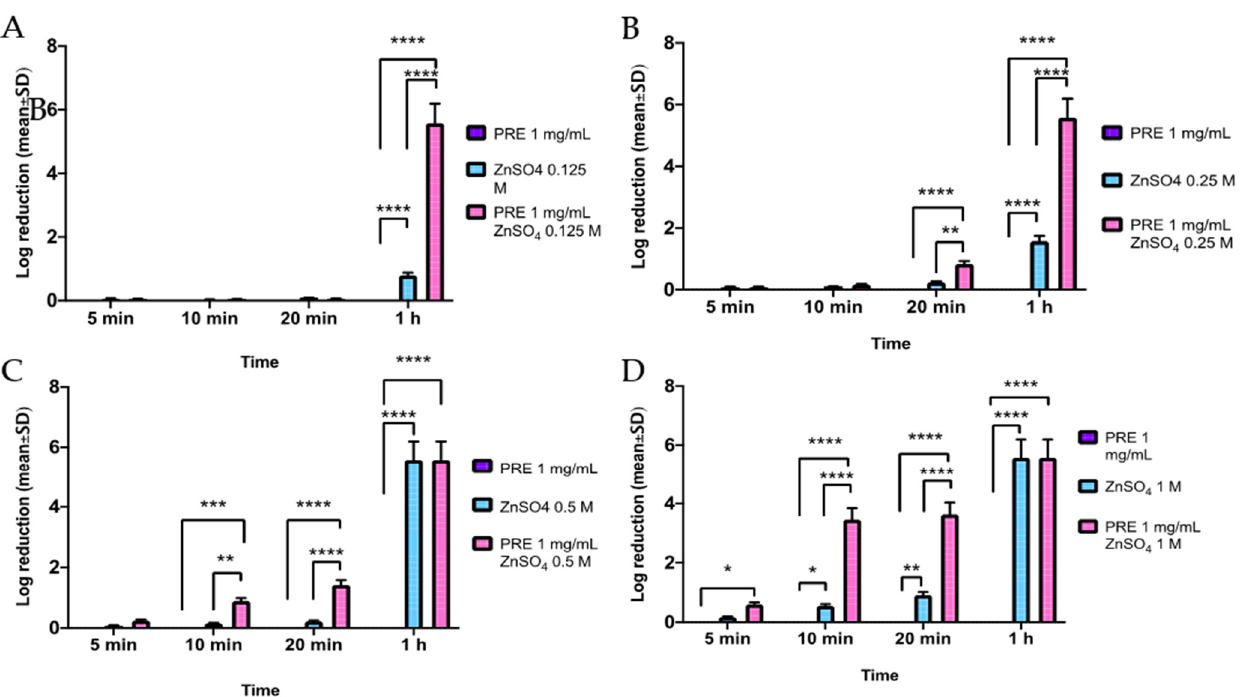
Figure 3. Log 10 reduction of S. epidermidis CFUs at incubation times of 5 min, 10 min, 20 min and 1 h ( n = 9 ± SD). ( A ) PRE (1 mg/mL) and Zn (II) (0.125 M), alone and in combination. ( B ) PRE (1 mg/mL) and Zn (II) (0.25 M) alone and in combination. ( C ) PRE (1 mg/mL) and Zn (II) (0.5 M) alone and in combination. ( D ) PRE (1 mg/mL) and Zn (II) (1 M) alone and in combination. Tukey’s multiple comparison post-hoc test show statistically significant differences (* p ≤ 0.05, ** p ≤ 0.01, *** p ≤ 0.001, **** p ≤ 0.0001).